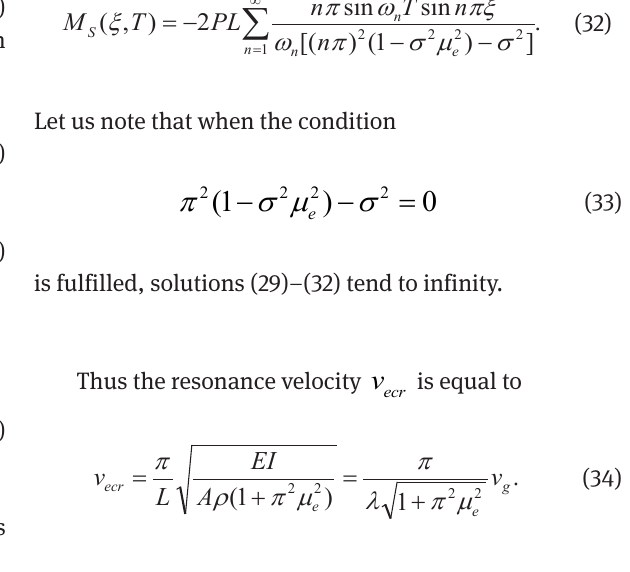
differential equations. (14) and (15). These functions do not satisfy the initial conditions of motion (19). ξ correspond to free vibrations of the beam and satisfy the ξ and ) , ( TM The functions ) , ( Tw S S homogeneous differential equations (14), (15) , and ), 0 ( = P and together with the aperiodic functions , the initial conditions of motion are satisfied. Now we will present the aperiodic solutions ) , ( Tw ξ given by expressions ( 29 ) and ( 31 ) in closed analytical form. ) , ( TM A